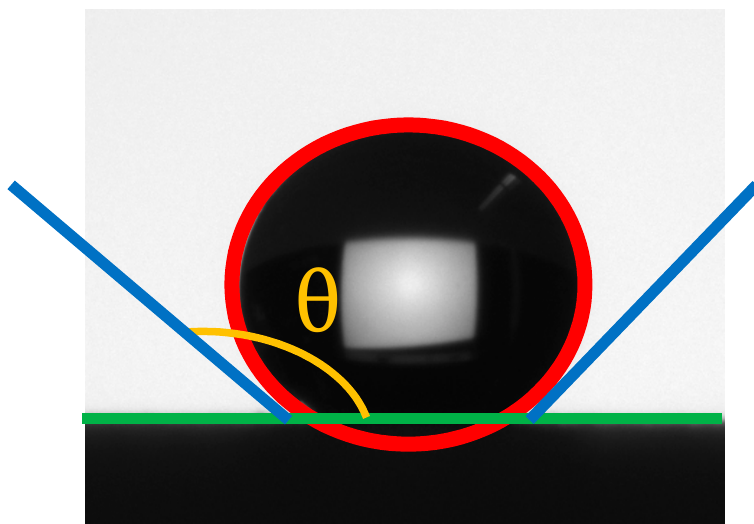
Figure 1. Contact angle of a water droplet on a superhydrophobic surface.